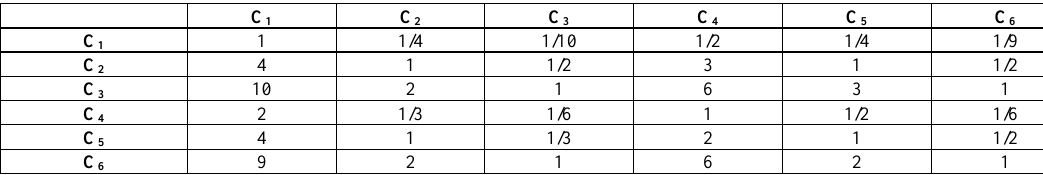
Table 10. The compared matrix among the criteria sets.